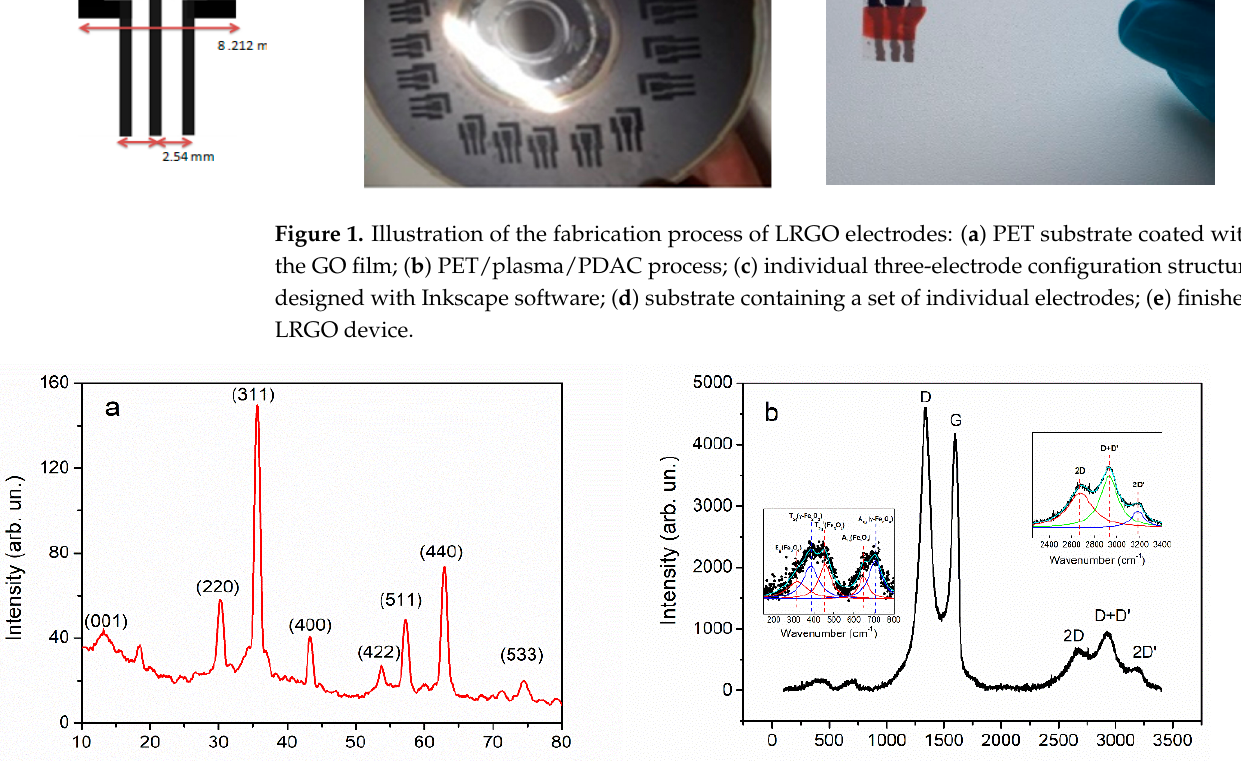
c Figure 2. The structural and morphological characteristics of the ION-RGO nanocomposite: ( a ) XRD diffractogram; ( b ) Raman spectrum where ION and RGO phases are readily detected; ( c ) TEM im- age of the nanocomposite where the RGO sheet is decorated with spherical-like ION. The ION-RGO nanocomposite sample was evaluated by X-ray diffractometry (Bruker D8 Diffractometer; Cu- Kα radiation λ = 0.154 nm; 0.05° resolution ; and 0.5° min − 1 rate), transmission electron microscopy (TEM, JEOL JEM-2100, at 200 kV), and Raman (Horiba T6400; 532 nm laser line; 0.1 cm − 1 resolution; laser power 2 mW) spectroscopy. In addition, the ION-RGO colloid was characterized by measuring the zeta potential and hydrodynamic diameter with a Nano Zetasizer ZS90 (Malver Instrument). Scanning elec- tron microscopy (SEM) images were carried out for the electrode-functionalized films us- ing FEI Nova Nano SEM 200. 2.3. Electrochemical Measurements All electrochemical experiments were carried out with a PalmSens 4 potentiostat at room temperature (25 °C). The electrochemical properties and stability of bare and PDAC/ION-RGO-modified LRGO electrodes was exclusively investigated by cyclic volt- ammetry (CV), both in the plain electrolyte phosphate-buffered saline (PBS) and with K 3 Fe (CN) 6 (1 mmol L − 1 in KCl 0.1 mol L − 1 ) as the redox probe, at different scan rates (25 mVs − 1